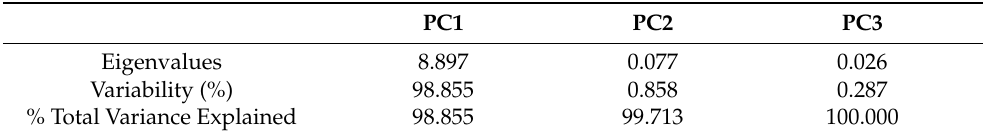
Table 8. Significant factors, extracted before the PCA